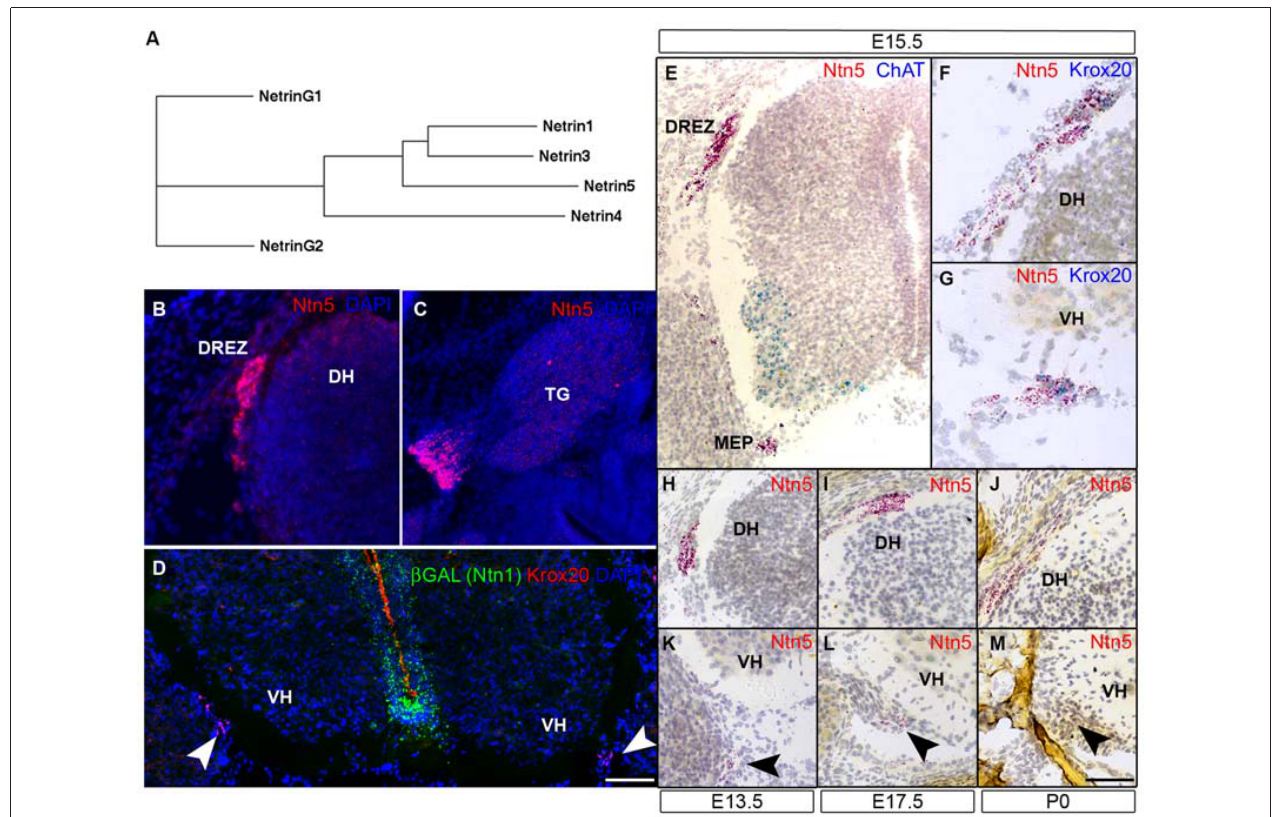
FIGURE 1 | Ntn5 is expressed in Boundary cap cells (BCC) . A dendrogram calculated from the primary amino acid sequences of mouse netrins demonstrates that netrin5 is more similar to netrin1 and netrin3 than is netrin4 (A) . Ntn5 expression was assayed by in situ hybridization. Using a riboprobe and tyramide signal amplification, expression was detected at the dorsal root entry zone (DREZ) of the spinal cord (B) and adjacent to the trigeminal ganglia (C) at embryonic day 15.5. By the ViewRNA branched DNA probe technique, expression was verified at the DREZ and detected at the motor exit point (MEP, motor neurons (MNs) labeled for ChAT, E ). Ntn5 -expressing cells at both locations were Krox20 -positive BCC (F,G) . Expression at the MEP was strongest between E13.5 and E17.5 (K,L) and was barely detectable at P0 (M) . Likewise, labeling at the DREZ peaked between E13.5–E17.5 (H,I) and was diminished by P0 (J) . In Ntn1 GT / + embryos immunostained for β Gal—a reporter of Ntn1 expression in these mice—there is no colocalization with Krox20-positive BCC (D) . TG, trigeminal ganglion; DH, dorsal horn of the spinal cord; VH, ventral horn. Scale bar is 550 µ m in (B,C,E) , 300 µ m in (F,G) , and 400 µ m in (D,H–M)